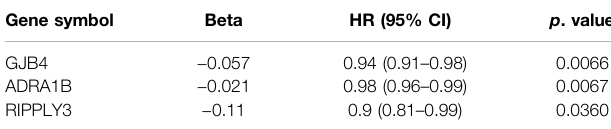
TABLE 2 | Univariate Cox regression analysis results.